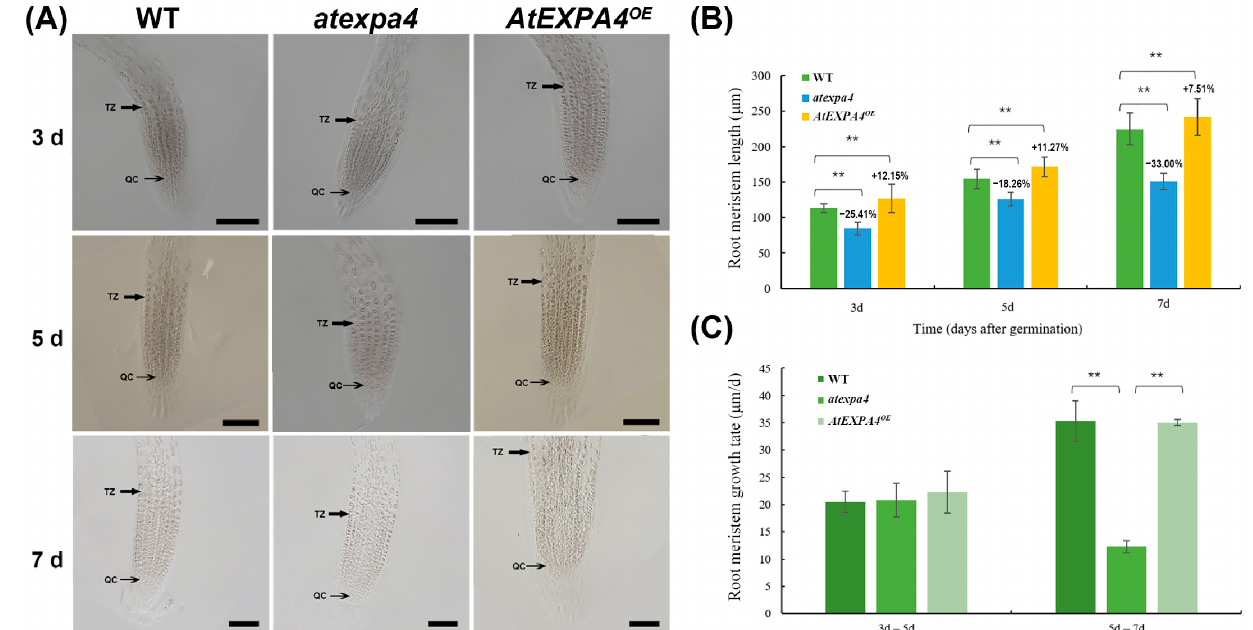
Figure 7. AtEXPA4 positively regulates root meristem length. ( A ) Differential interference images of AtEXPA4 OE and atexpa4 root meristem boundary after seed germinated for 3, 5, and 7 days, scale bars, 100 μ m. ( B ) Root meristem lengths in ( A ). ( C ) Root meristem growth rates from the 3rd day to the 5th day and from the 5th day to the 7th day after seed germination. Values are means, error bars are SD, n ≥ 25 seedlings per replicate, three biological replicates, t -tests as ** p < 0.01.